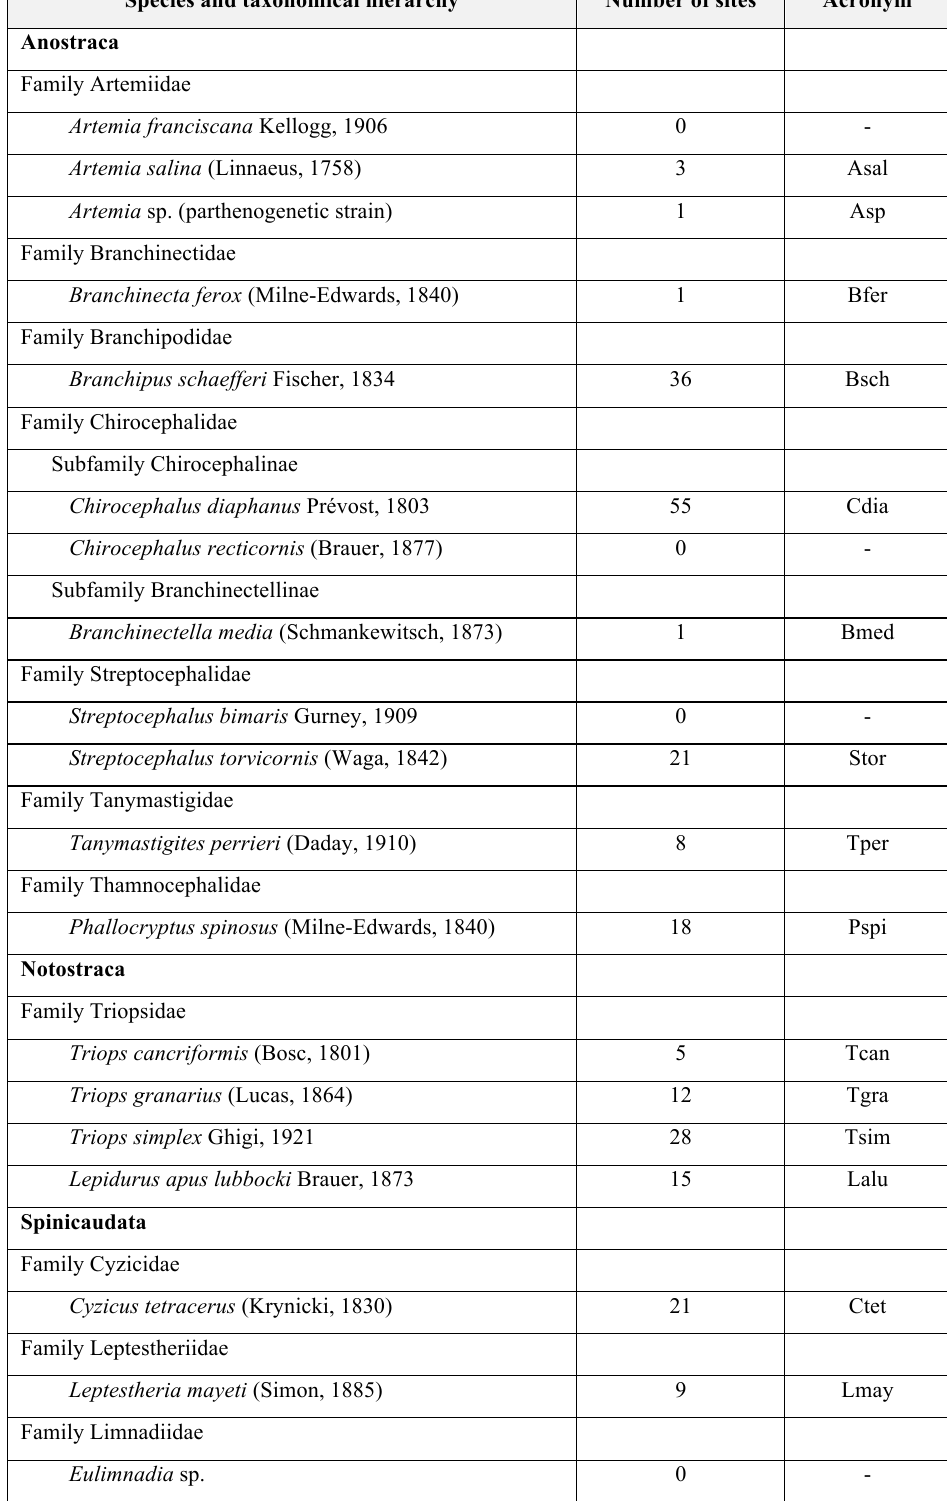
TABLE 2. List of large branchiopod species occurring in Tunisia. For each species, the number of sites at which the species was observed in the course of the current survey is reported. The acronyms refer to the codes used in Table